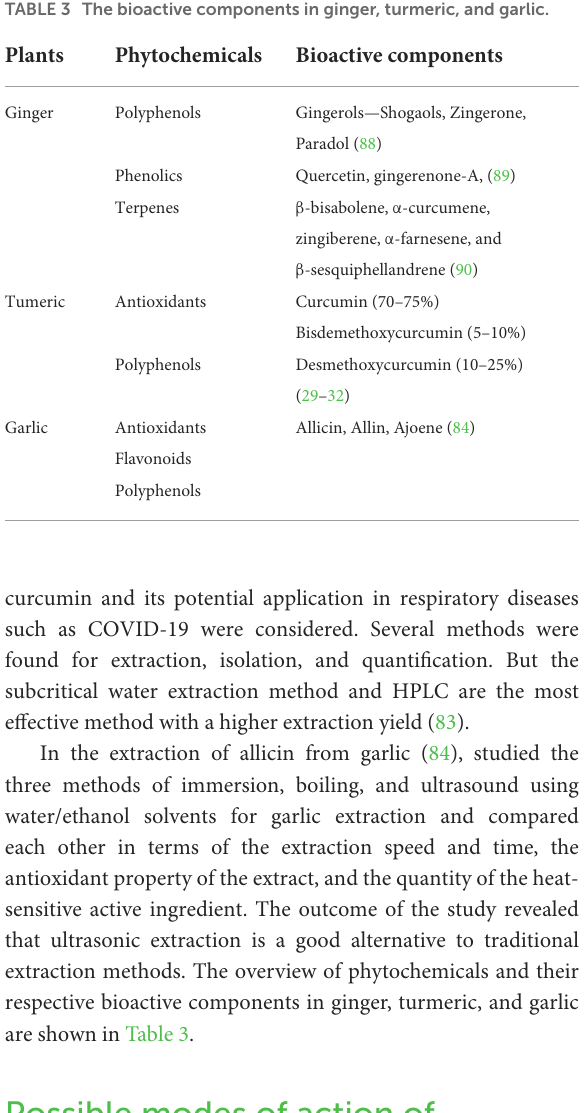
TABLE 3 The bioactive components in ginger, turmeric, and